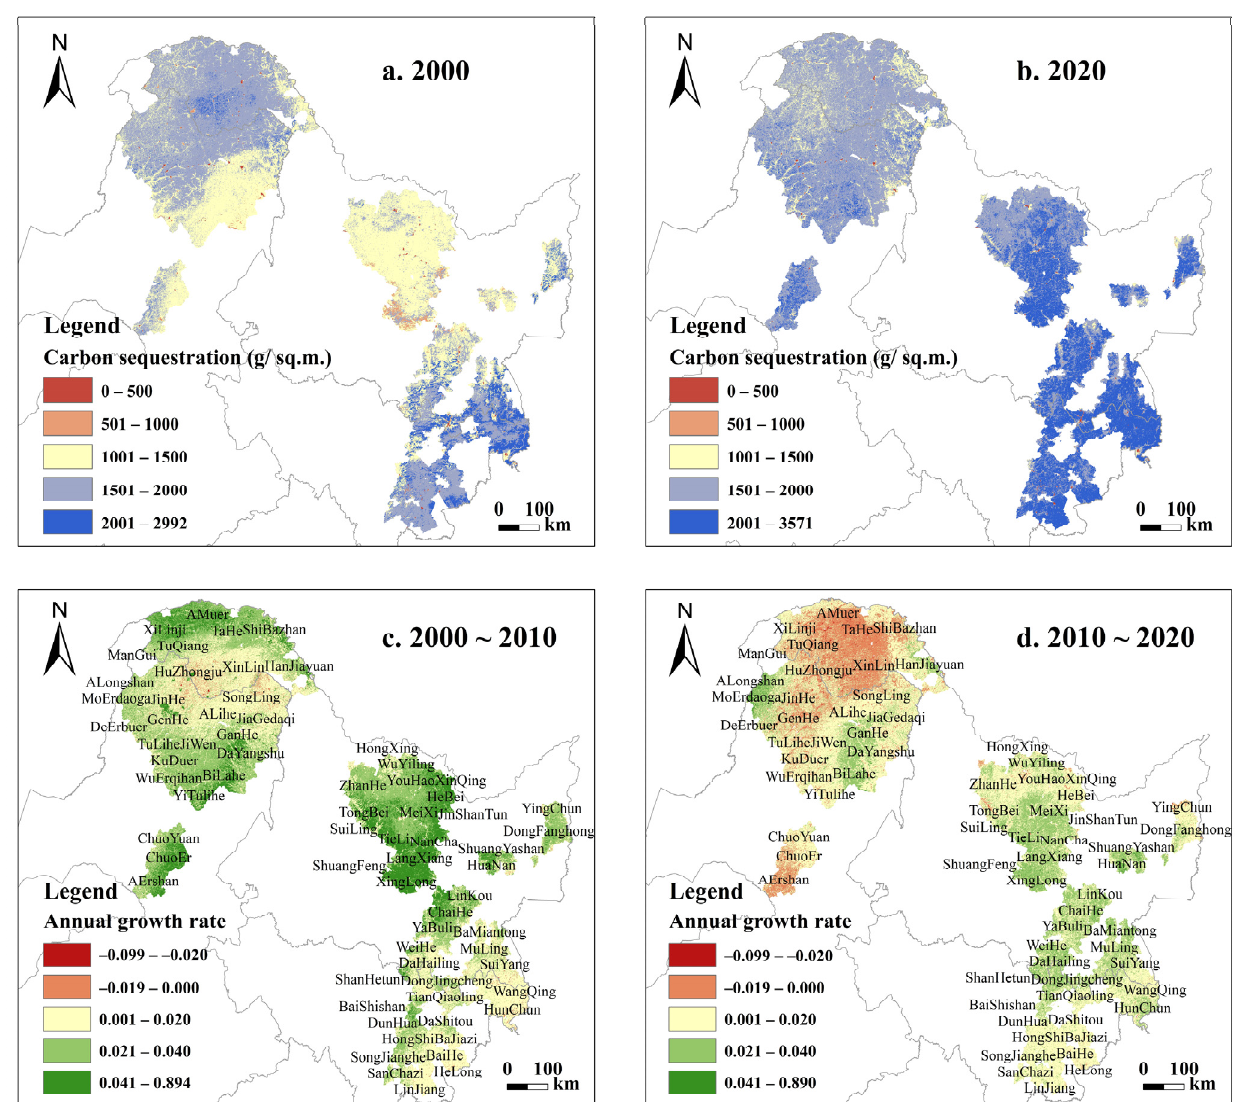
Figure 4. Map of spatial change in carbon sequestration growth rate. ( a ) Carbon sequestration in 2000; ( b ) Carbon sequestration in 2020; ( c ) Annual growth rate from 2000 to 2010; ( d ) Annual growth rate from 2010 to 2020. ( c , d ) show the names of the SOFEs.